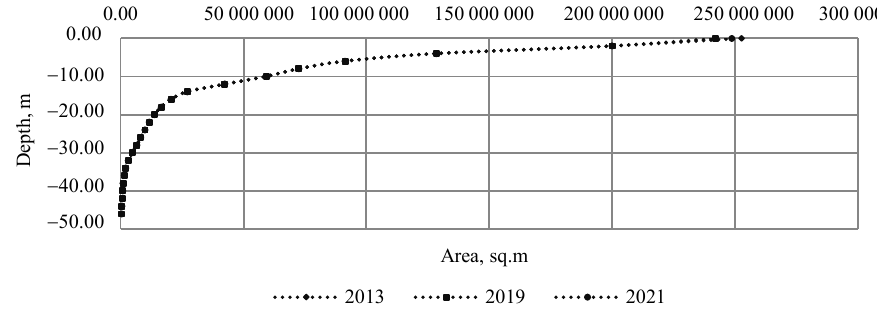
Fig. 3. Bathygraphic curve of Svitiaz Lake up to 45 m depth (dependence between area and depth).